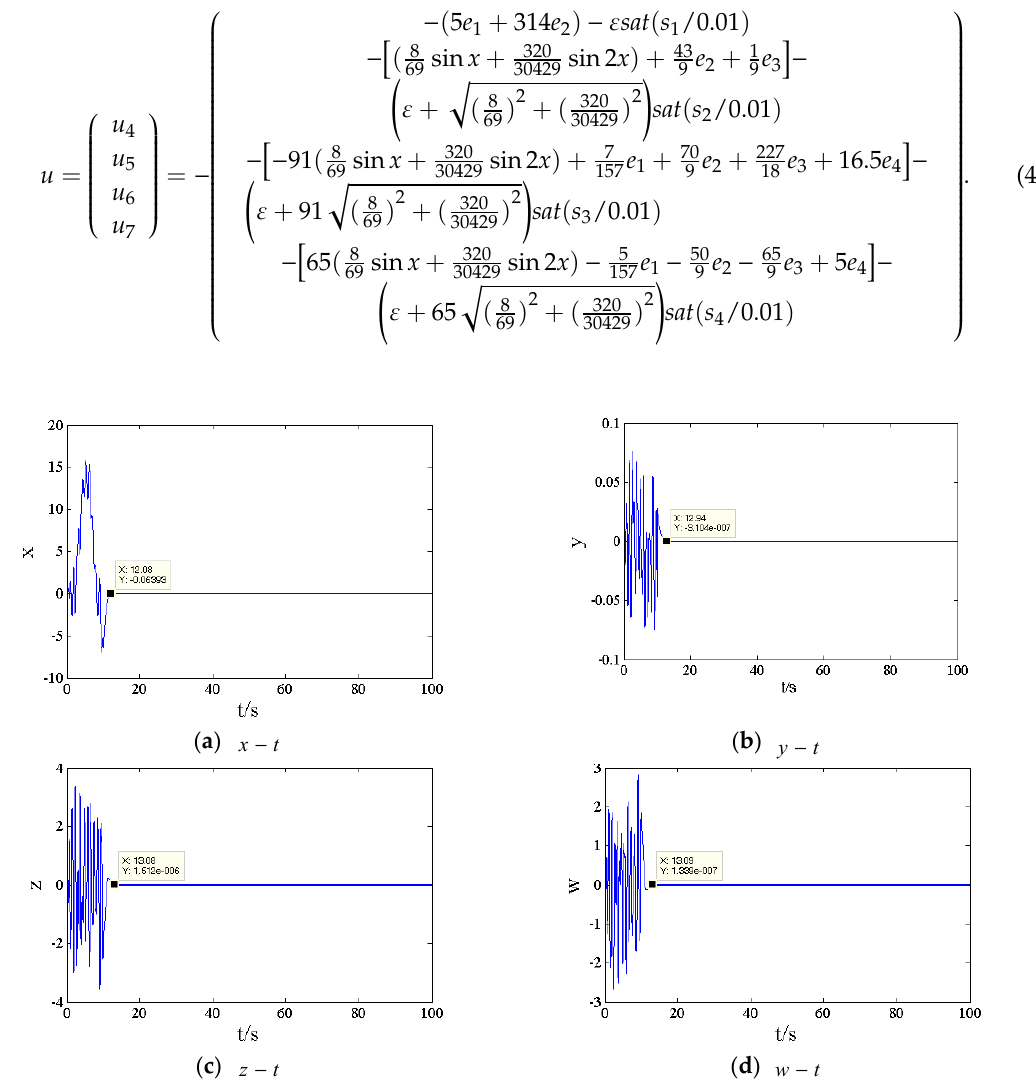
Figure 4. State trajectories of the HGS (18) with Controller (40). ( a ) x − t ; ( b ) y − t ; ( c ) z − t ; ( d ) w − t